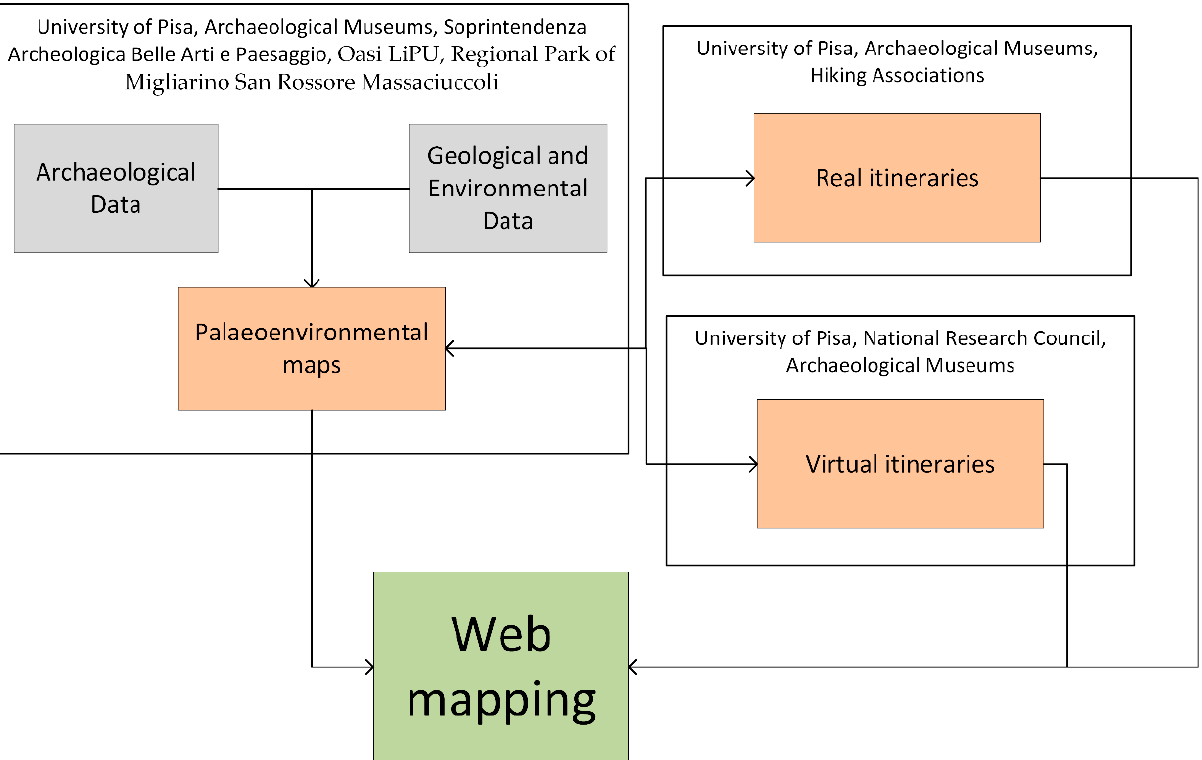
Figure 2. Research flowchart. The diagram shows the stakeholders involved in each section of the work. The grey rectangles are the bibliographic data, the red rectangles are the intermediate results and the green rectangle is the final result.